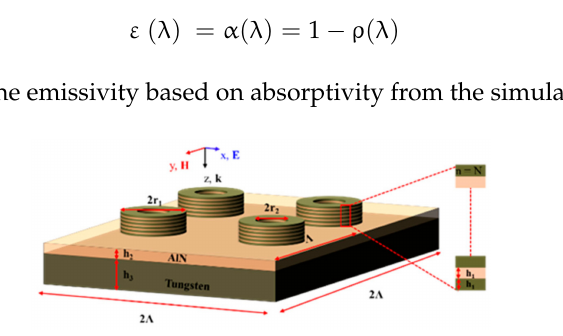
Figure 1. Schematic representation of the designed metamaterial